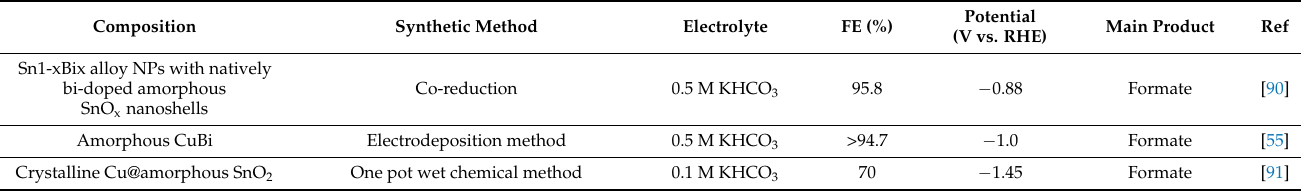
Table 5. Comparison of amorphous bimetallic electrocatalysts for CO 2 RR in the literature.